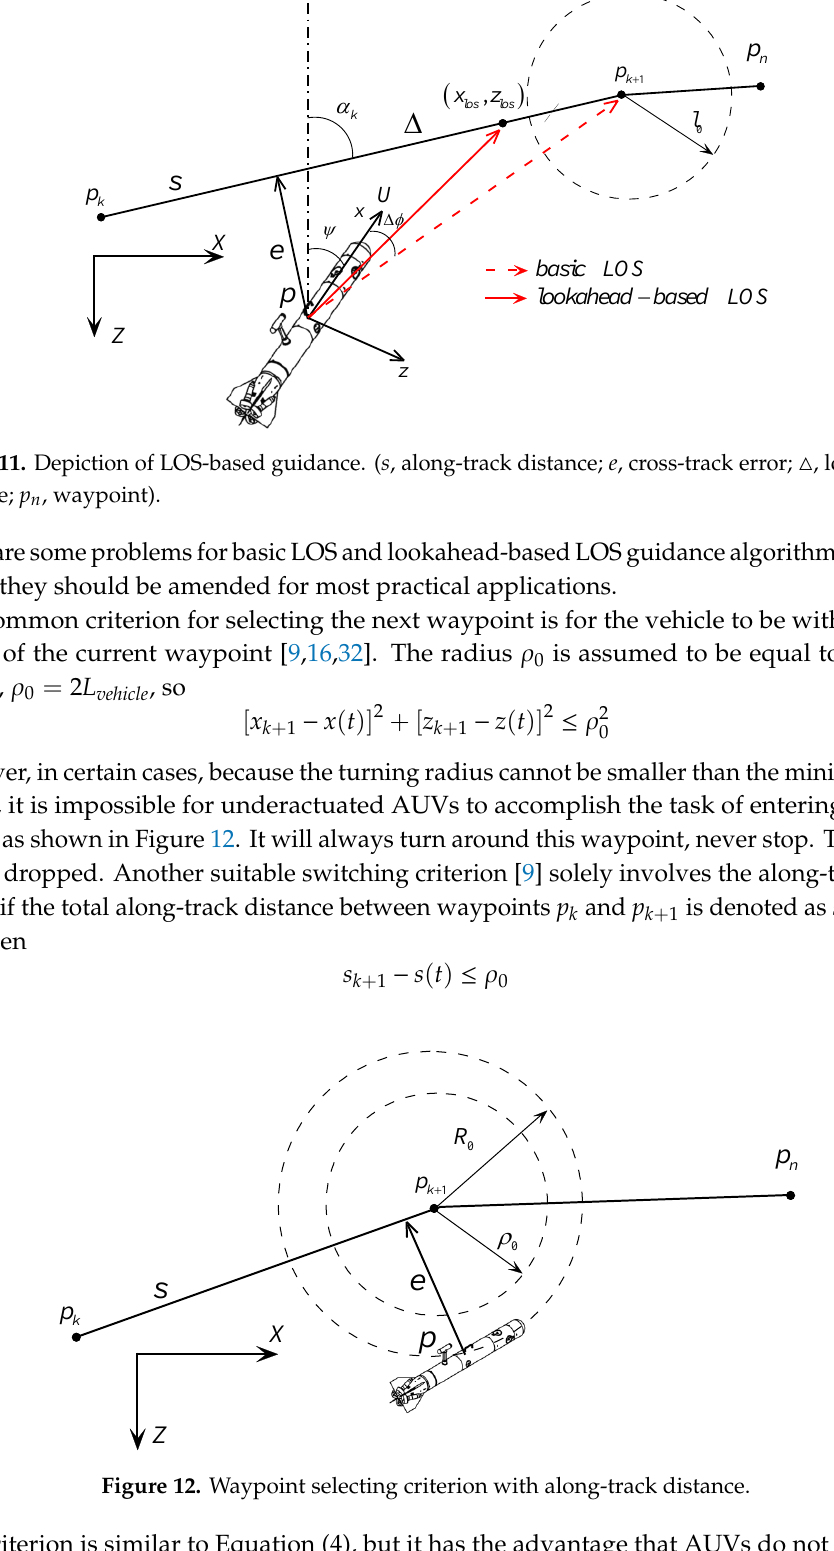
Figure 13. Following the square path with lookahead-based LOS. As seen from Figure 13, the red line is the desired path, a small lookahead distance ( △ ) will induce more aggressive steering, a large lookahead distance results in smoother steering, but the downside is slower convergence to the path. △ is typically expressed as n vehicle lengths [32]. As seen from Figure 13, the optimal distance is △ = 10 m, the corresponding simulation result is shown as the blue solid line, there is no unwanted oscillations around the path, and ZFAUV can converge to the desired path. However, no matter △ is large, small, or time-varying, there is large overshoot at corners. The maximum overshoot is approximately 8.9 m. When △ = 10 m, it convergences to the desired path after 40 m. Taking the maximum error of 2 m as the standard, only 75% of the actual trajectory convergences to the desired path, and this number drops to 67% if the first side is not considered (the initial heading angle is the same as that of the first path angle, so there is no error). The problem becomes more serious when there are sharp corners on the path. So, another desired path-2 consists of a total of 2 waypoints: {X 1 = 100, Z 1 = 0; X 2 = 50, Z 2 = −86.6}, as shown in Figure 14. The maximum overshoot is approximately 14 m (